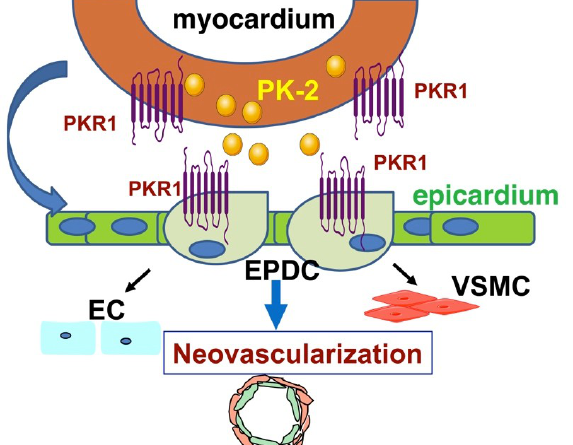
Figure 2. A novel cardiomyocyte-epicardium interaction via prokineticin/PKR1 signaling. Cardiomyocyte PKR1 signaling upregulates its own ligand, prokineticin-2 (PK-2), as